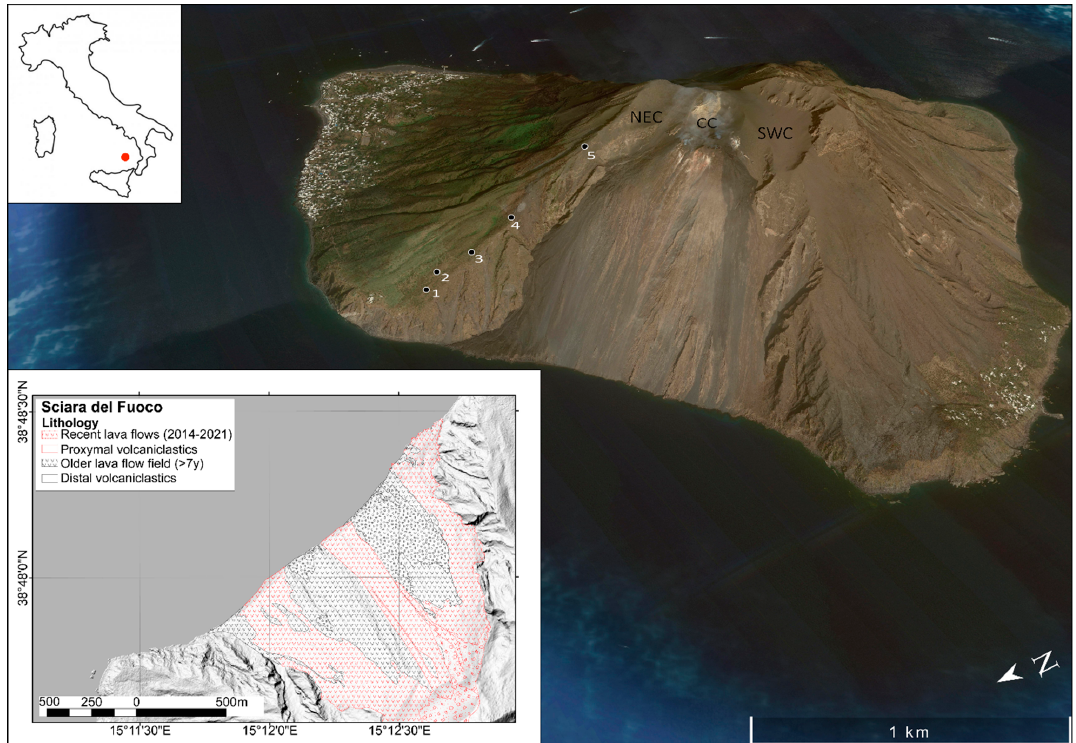
Figure 1 . Sciara del Fuoco, Stromboli Island (image from Google Earth). Numbered dots refer to the take-off points. Locations of main craters (NEC: North East Crater; CC: Central Crater; SWC: South West Crater) are reported. On the left, the lithological map of the Sciara del Fuoco (modified after [42,43]).